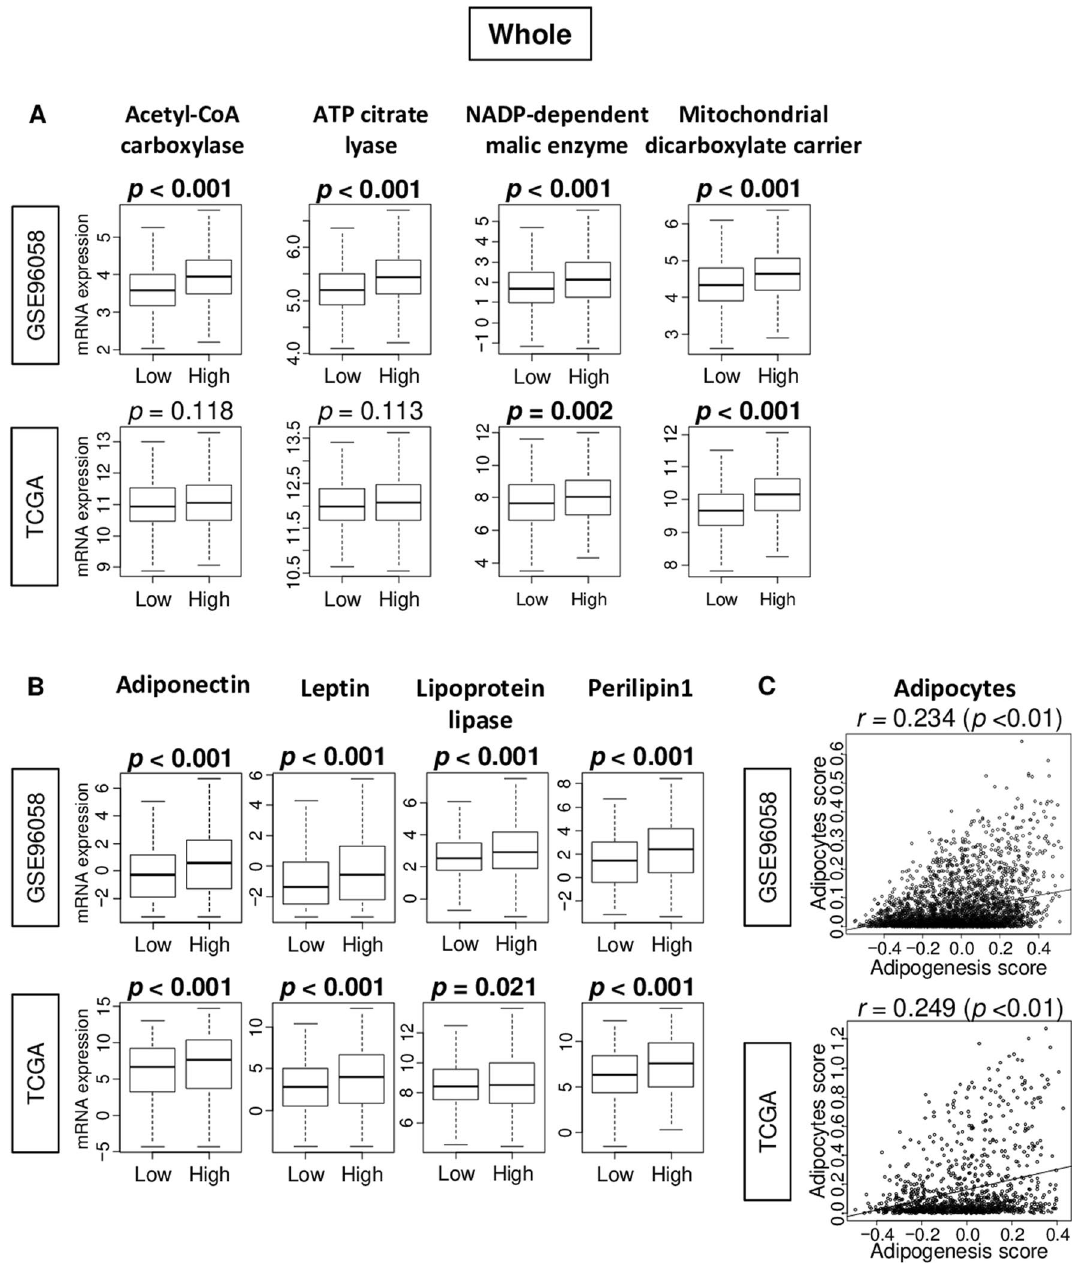
Figure 1. Association of the adipogenesis score with expression of adipogenesis- and adipocyte-related genes, and correlation with adipocyte score in the GSE96058 and TCGA cohorts. Boxplots comparing low and high adipogenesis score tumors of gene expression levels of (A) adipogenesis-related genes; Acetyl-CoA carboxylase/ ACLY , ATP citrate lyase/ ACACA , NADP-dependent malic enzyme/ SLC25A10 , and mitochondrial dicarboxylate carrier/ ME1 , and (B) adipocyte-related genes; adiponectin/ ADIPOQ , leptin/ LEP , lipoprotein/ LPL , and perilipin 1/ PLIN1 in breast cancer. P -value was calculated using Mann–Whitney U test. (C) Correlation pots between adipogenesis and adipocytes scores. Spearman correlation coefficient ( r ) was used to the